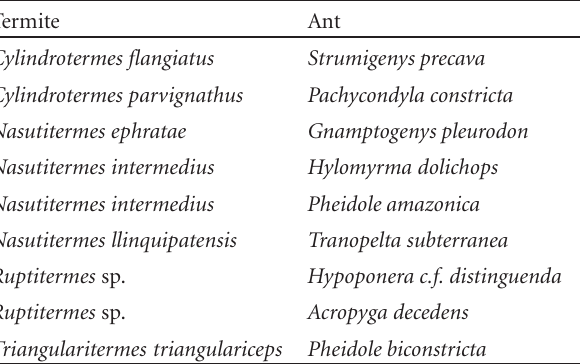
Table 3: Ant and termite species collected in the same nest/food source. Termite species were found inside the same twig as the ant species listed next to them, though in separate chambers. Ants and termites were not found to occupy the same galleries within a twig.